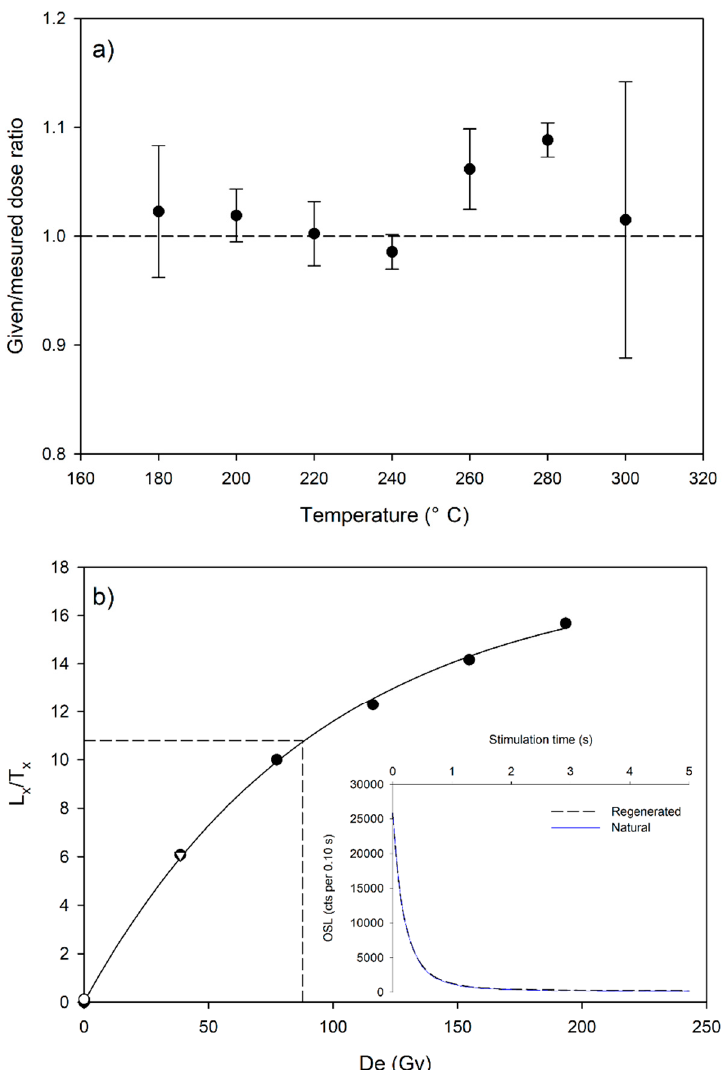
Figure 2. ( a ) Dose recovery ratio as a function of first preheat temperature for sample 1141. There were 3 aliquots used per preheat temperature and the error bars represent 1 standard error. The dashed line is drawn at an ideal ratio of 1.0. ( b ) Representative sensitivity-corrected dose–response curves for sample 1141. The dashed line shows the equivalent dose. The response to a zero dose is depicted as an open circle, while the recycling point is represented as an open inverted triangle. The inset displays a typical decay curve of natural CW-OSL (continuous-wave OSL signal) (full blue line) for the first 5 s of stimulation in comparison to a regenerated signal (dashed black line) induced by a beta dose approximately equal to the equivalent dose.